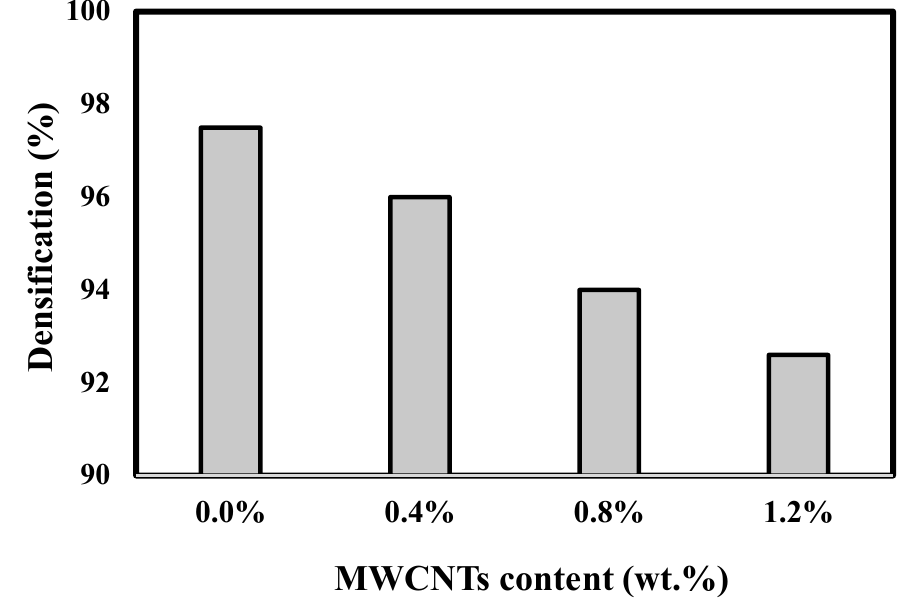
Figure 5. Density of MWCNT content on Cu nanocomposites. Table 2. The relative density of Cu-MWCNTs.